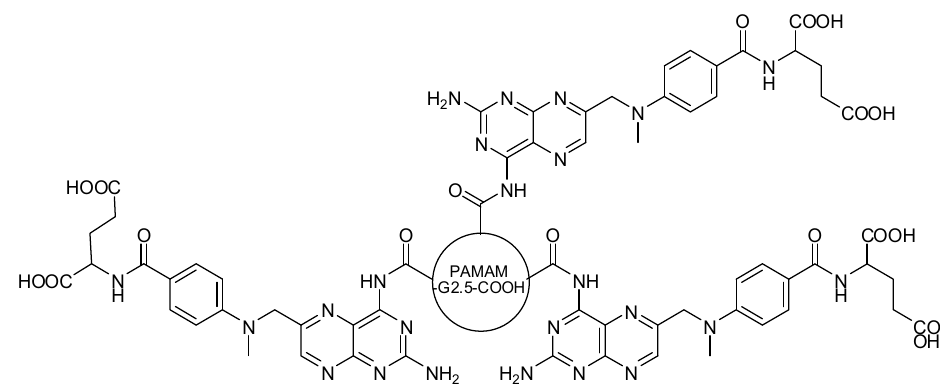
Figure 16. Dendrimer prodrug designed with PAMAM-G2.5-COOH-methotrexate [67].